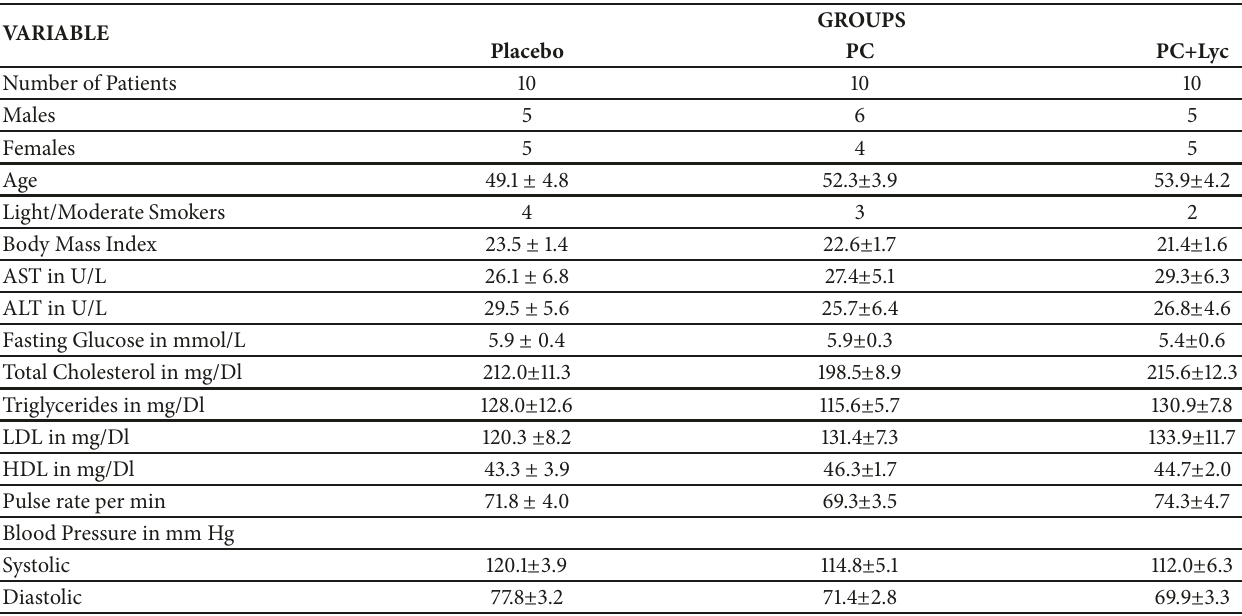
Table 1: baseline characteristics (averages ± SD). The volunteers were enrolled, screened, and randomized as described in the Material and Methods. The baseline parameters were measured at day “0” of clinical trial before ingesting the study products.